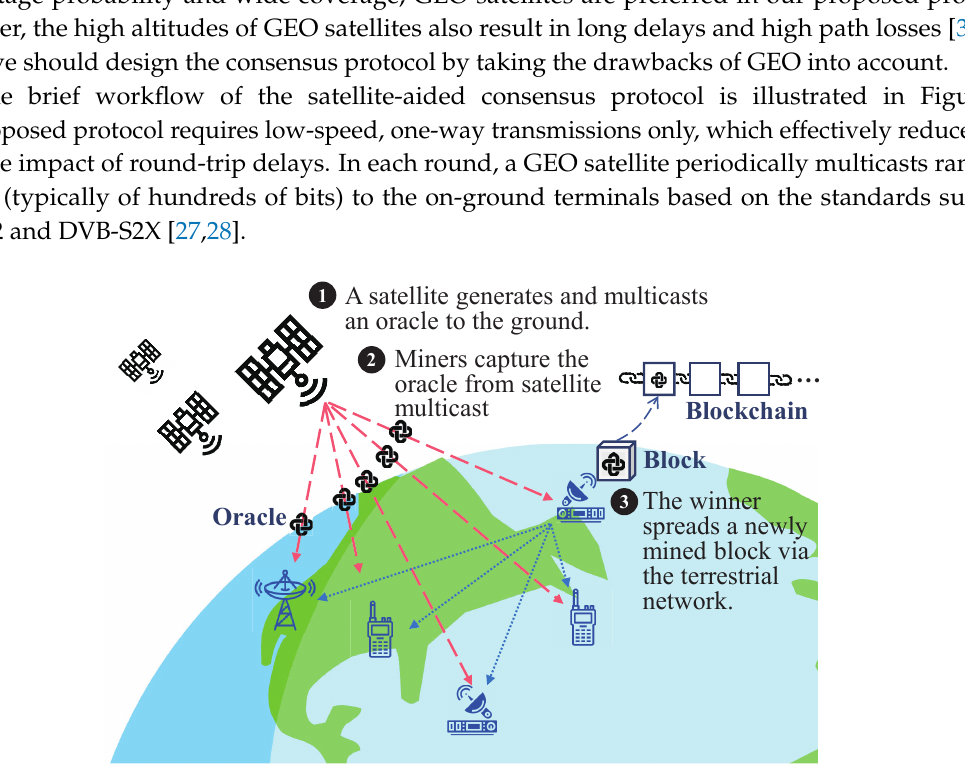
Figure 1. The illustration of the proposed satellite-aided consensus